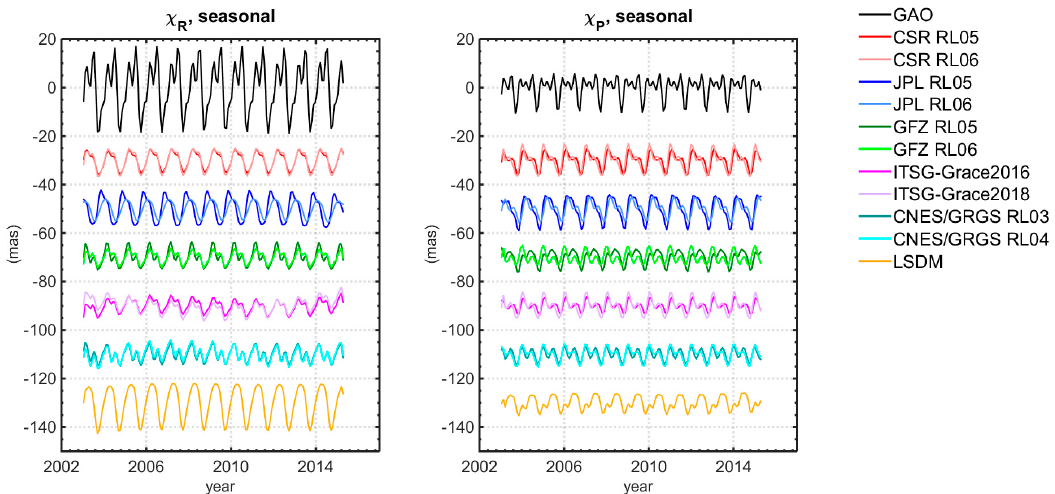
Figure 1. Retrograde and prograde parts ( χ R and χ P , respectively) of seasonal variation in geodetic angular momentum (GAM)–atmospheric angular momentum (AAM)–oceanic angular momentum (OAM) (GAO), in hydrological angular momentum (HAM) computed from different Gravity Recovery and Climate Experiment (GRACE) solutions, and HAM from the land surface discharge model (LSDM). The units are milliseconds of arc (mas). For better visibility, a bias was added to various HAM in order to shift them relative to each other. ITSG, Institute of Theoretical Geodesy and Satellite Geodesy; GFZ, GeoForschungsZentrum; CSR, Centre for Space Research; JPL, Jet Propulsion Laboratory; CNES/GRGS, Centre National d’Etudes Spatiales/Groupe de Recherche de Géodésie Spatiale.